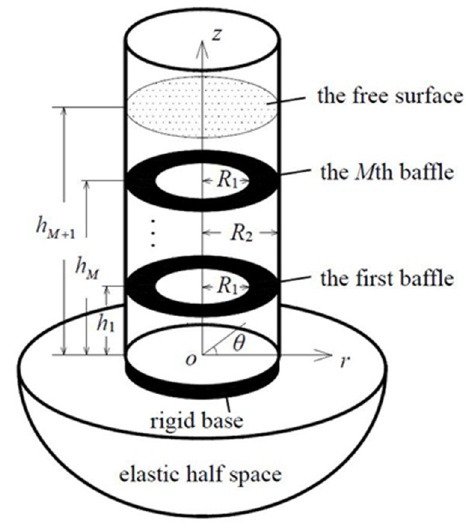
Figure 1. Soil–tank coupling system.